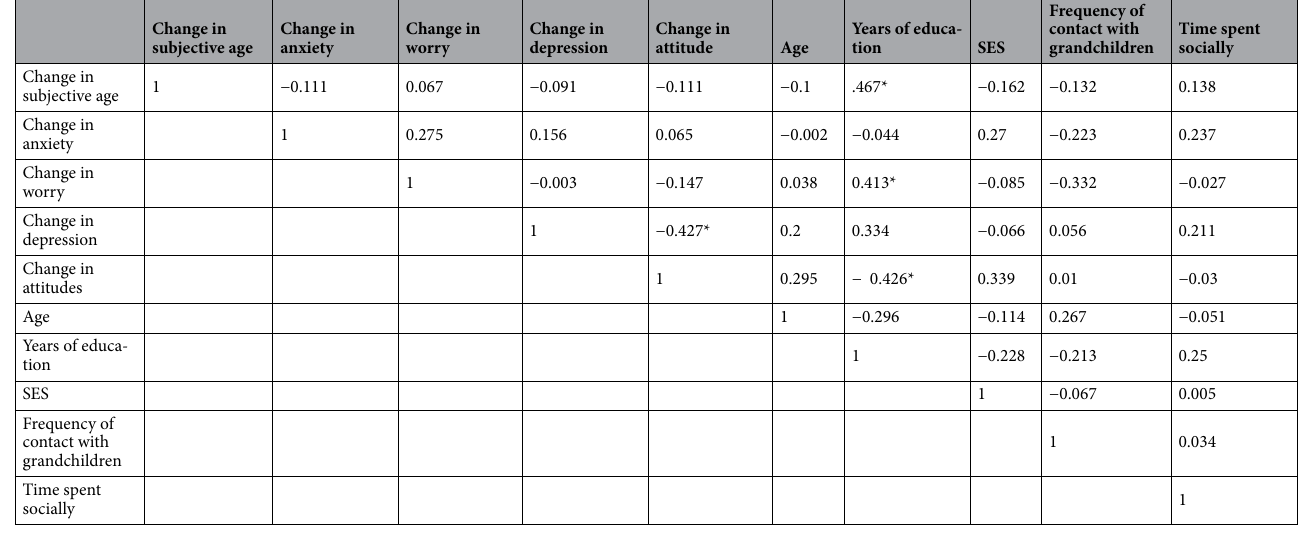
Table 5. Analysis of measures before and after the interventions. * p < .05, **p <